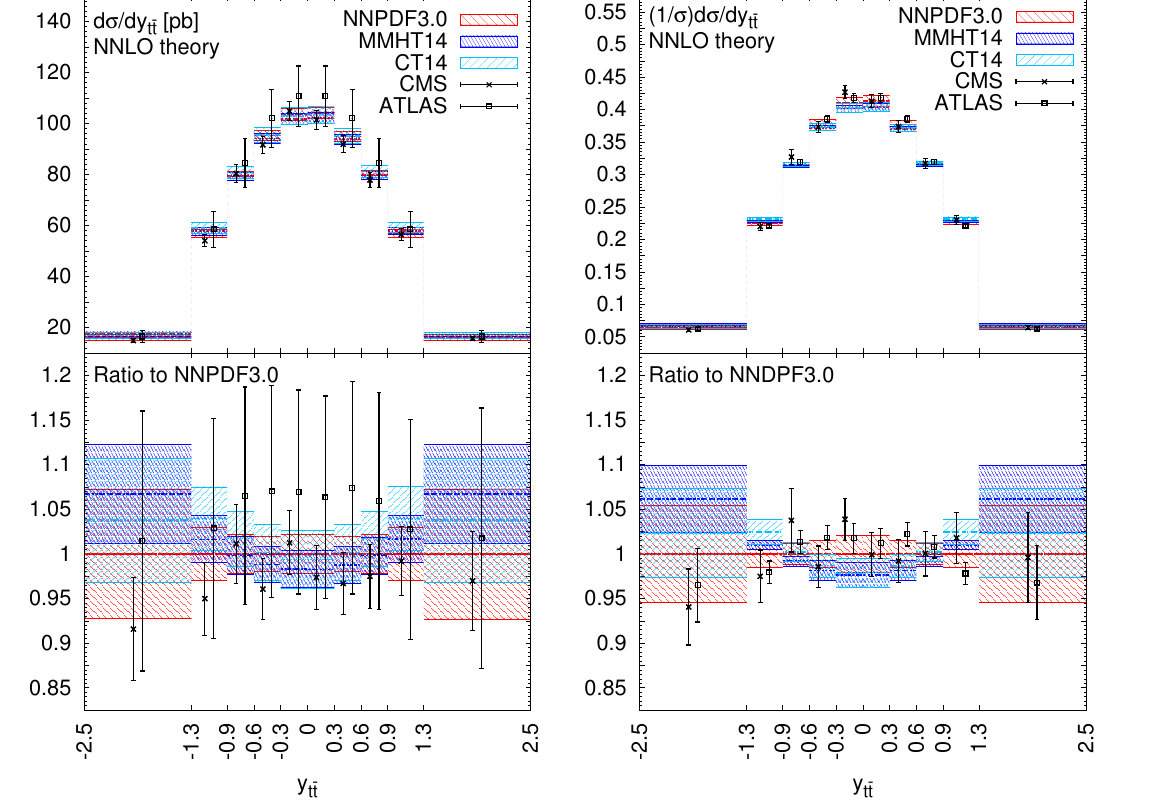
Figure 9 . Same as (cid:12)gure 5 for the rapidity distribution of the top-quark pair, y t (cid:22) t